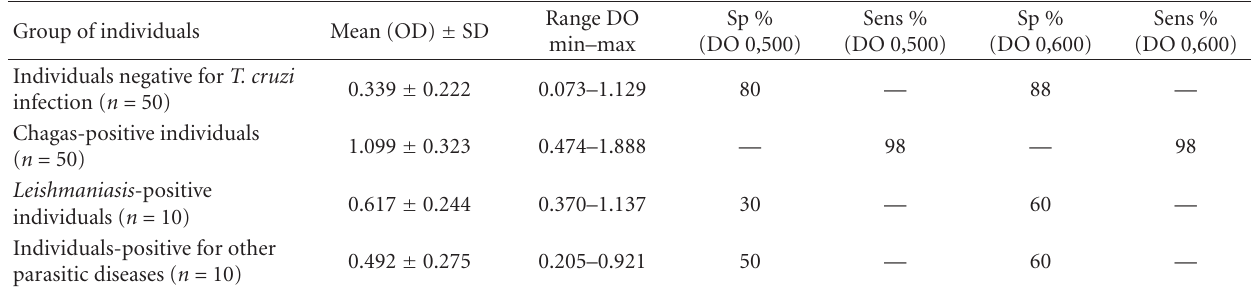
Table 2: Mean, standard deviation (SD), optical density range (OD), and specificity estimates for serum groups in ELISAs based on secreted and excreted antigen homogenates (ESEA antigens) from trypomastigote forms of T. cruzi . Group of individuals